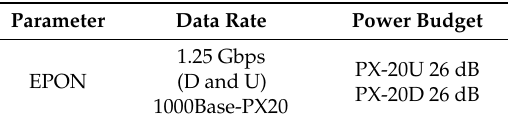
Table 2. IEEE STD 802.3 EPON specifications.